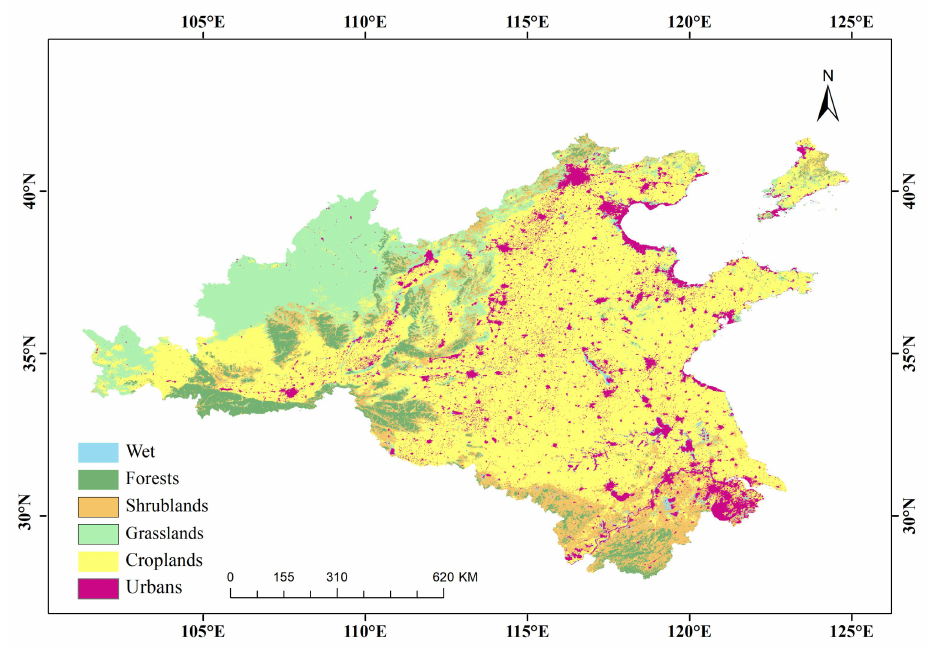
Figure 1 . The distribution of land cover types in the study